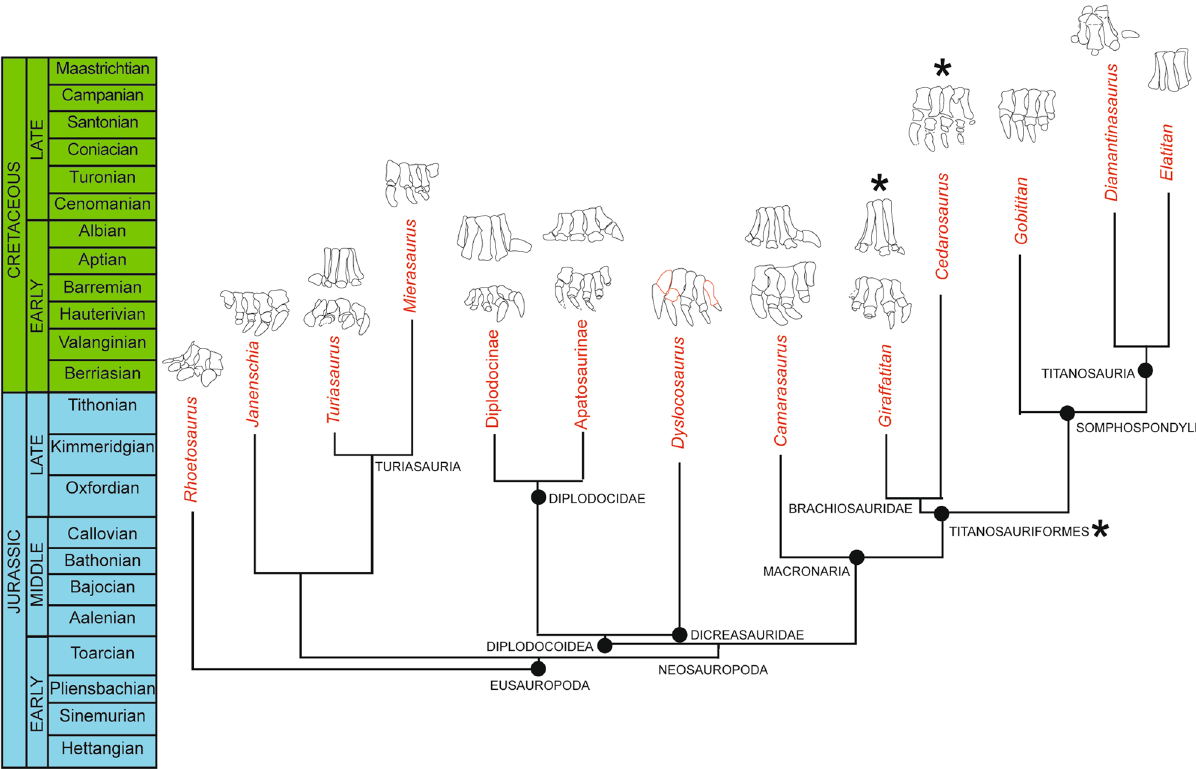
(pes and manus redrawn from 4 ); Mierasaurus (pes redrawn from 100 ); Diplodocinae (pes of Diplodocus carnegii redrawn from 101 ; manus of an indeterminate diplodocinae following 102 , redrawn from 103 ); Apatosaurinae (pes of Apatosaurus louisae and manus of Brontosaurus parvus redrawn from 104 ); Dicreasauridae (pes of Dyslocosaurus redrawn from 105 ); Camarasaurus (pes of C. lentus redrawn and reversed from 90 , manus of Camarasaurus grandis (or sp) redrawn from 106 see 94 ); Giraffatitan (manus redrawn from 107 , pes redrawn from 96 ); Cedarosaurus (pes redrawn from 108 ); Gobititan (pes redrawn from 109 ); Diamantisaurus (manus redrawn from 88 ); Elatitan (manus redrawn from 110